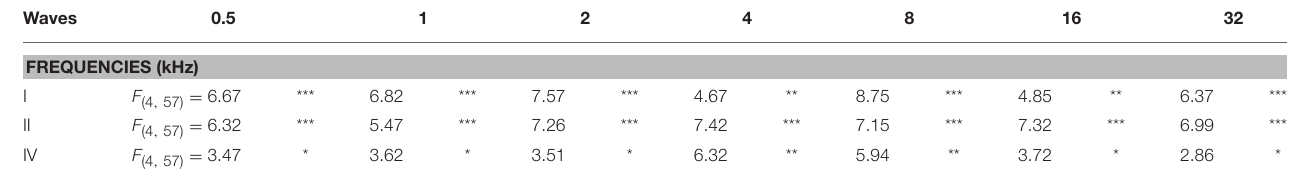
TABLE 3 | ANOVA analysis of the interaction between the time post-exposure and the wave amplitudes. Waves 0.5